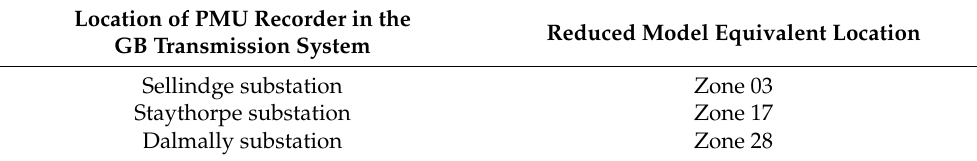
Table 2. Selected locations for